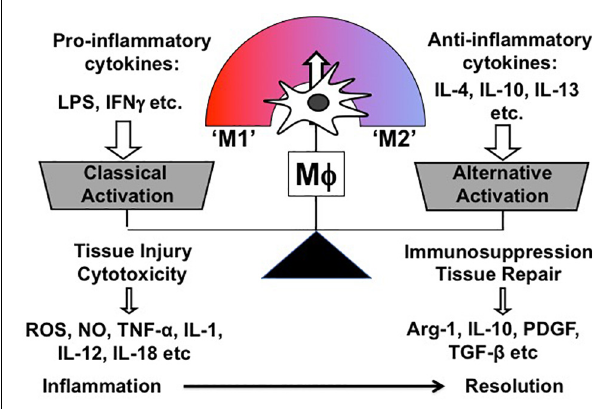
FIGURE 3 | Schematic representation of M φ polarization in vitro